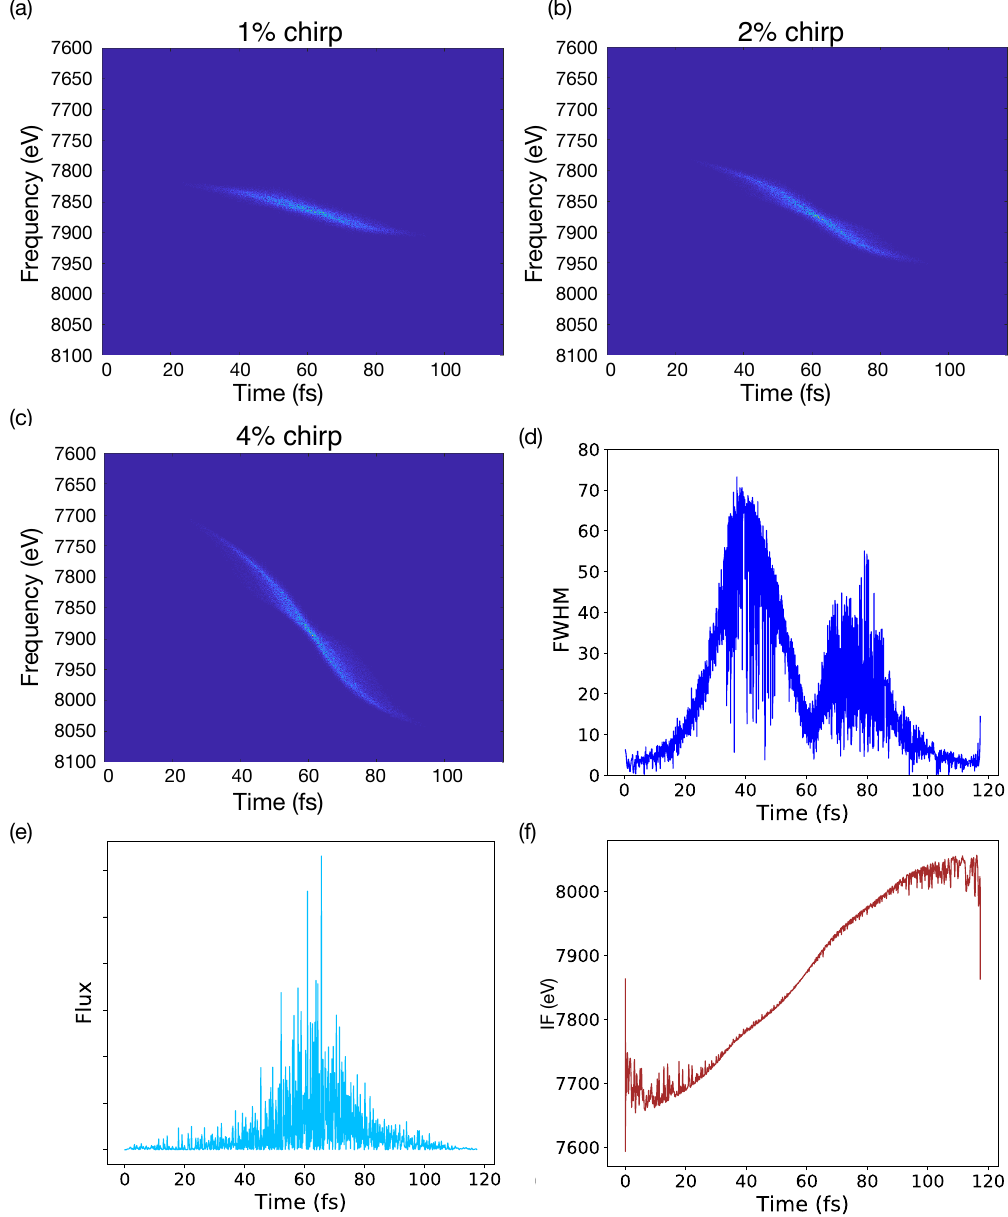
Figure 2. SwissFEL pulse characterization. Wigner–Ville distribution (WVD) for three available chirps: ( a ) 1% ( b ) 2%, and ( c ) 4%. ( d , e , f ) pulse characterization of the entire 120-fs 4% chirp SwissFEL pulse provided by analysis of the WVD. Instantaneous full width half maximum (FWHM in ) ( d ) flux ( e ) and IF ( f ) values are plotted. The frequency chirp is observable in the IF increase over time and the FWHM in is seen to change across the pulse. The highest frequencies are the first to arrive at the